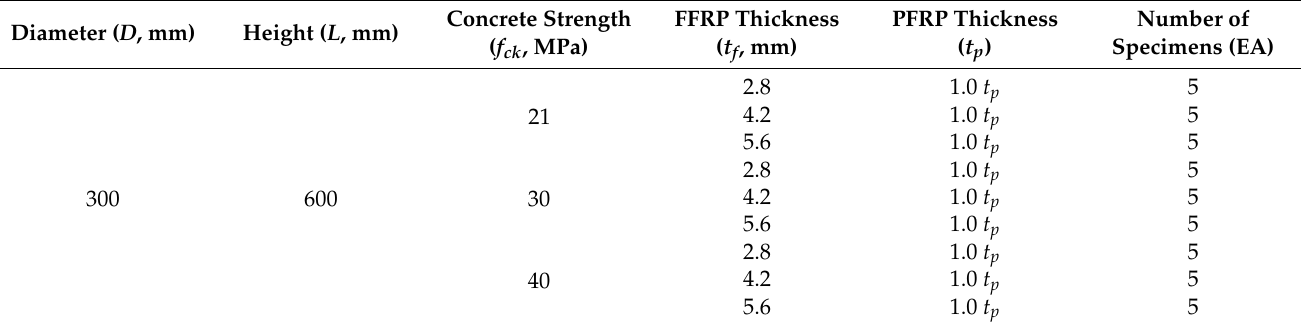
Table 8. Type and quantity of the hybrid-CFFT